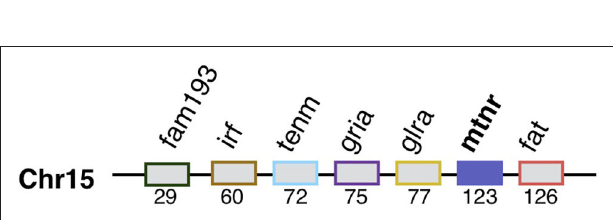
FIGURE 5 | Mtnr gene neighborhood in the pre-vertebrate genome. Mtnr and its syntenic genes were mapped from the gene list of the pre-1R ancestral genome reconstruction (Genomicus 69.10). The gene pre-1R gene list is available for download on the Genomics webserver and (115). The gene order is